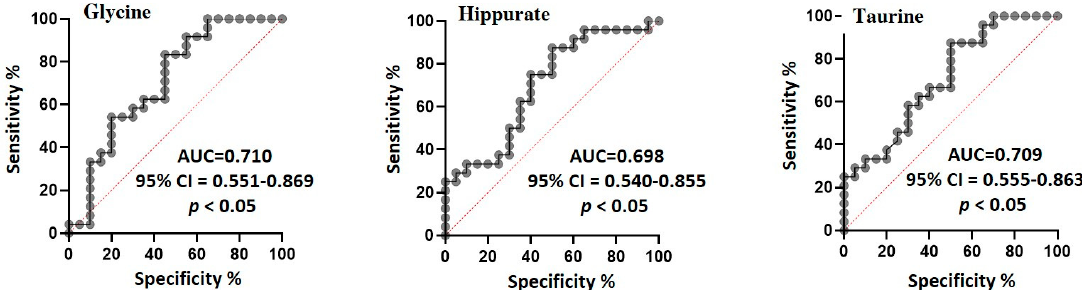
Figure 5. Receiver operating characteristic (ROC) analysis of glycine, hippurate, and taurine for differentiating BAV patients from healthy controls.